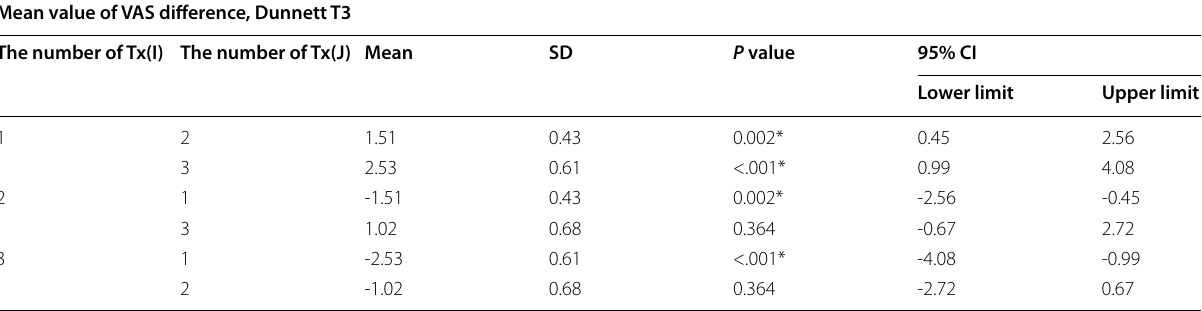
*Data sharing the symbol (*) differ significantly ( P